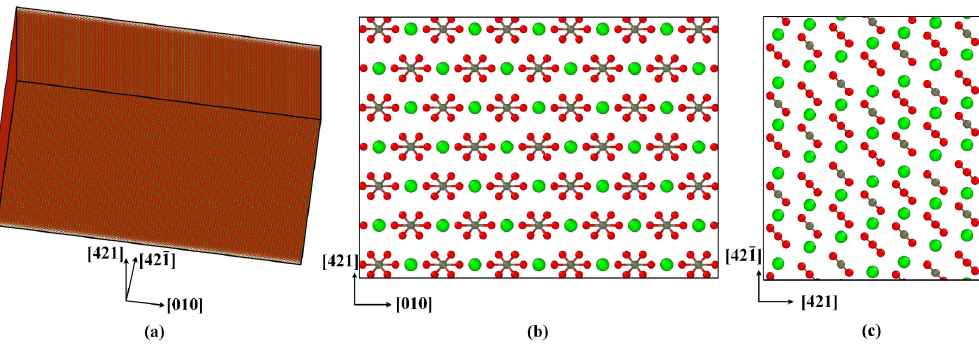
Figure 2. Computer model of single-crystal calcite: ( a ) 3D view, ( b ) top view, and ( c ) side view.